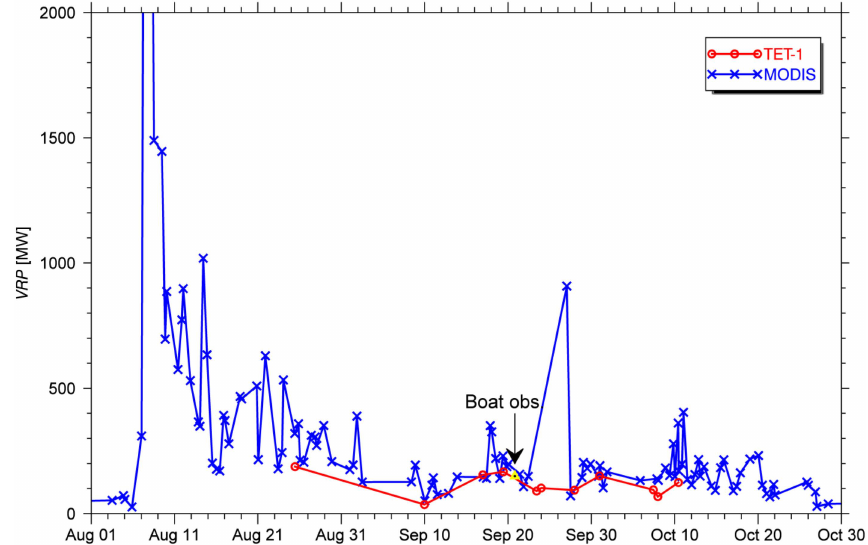
Figure 7. VRP in MW as observed from TET-1, MODIS, and field